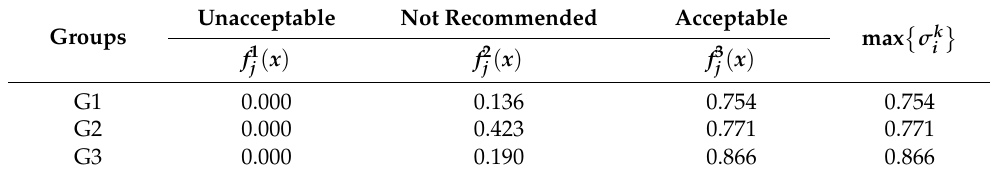
Table 12. Inverse of standard data.